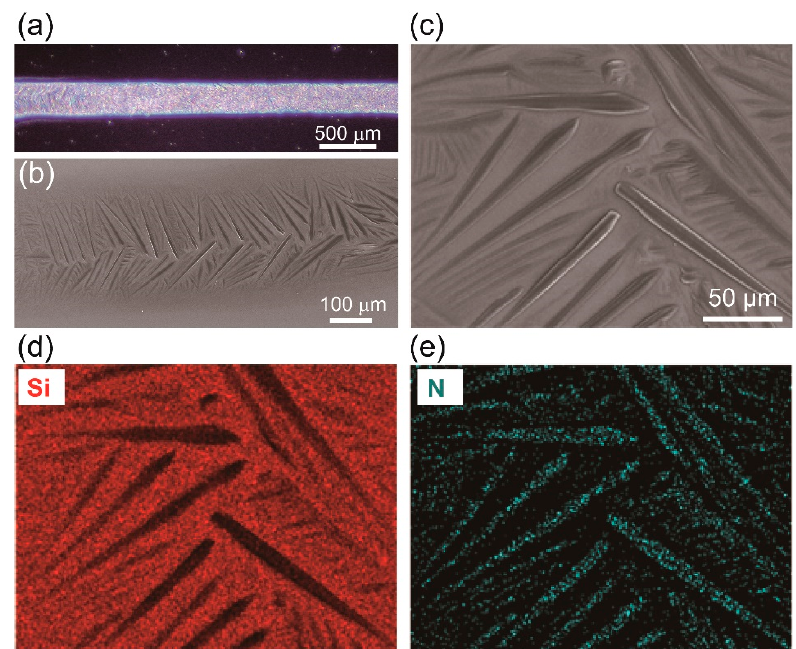
Figure 4. ( a ) An RDX micro-pattern printed on the UV-ozone (UVO)-treated surface of a Si wafer. ( b ) Dendrite crystal structures of RDX grown along the micro-pattern. ( c ) Higher magnification image of the dendrite crystal structure. ( d , e ) EDS composition mapping of the surface shown in ( c